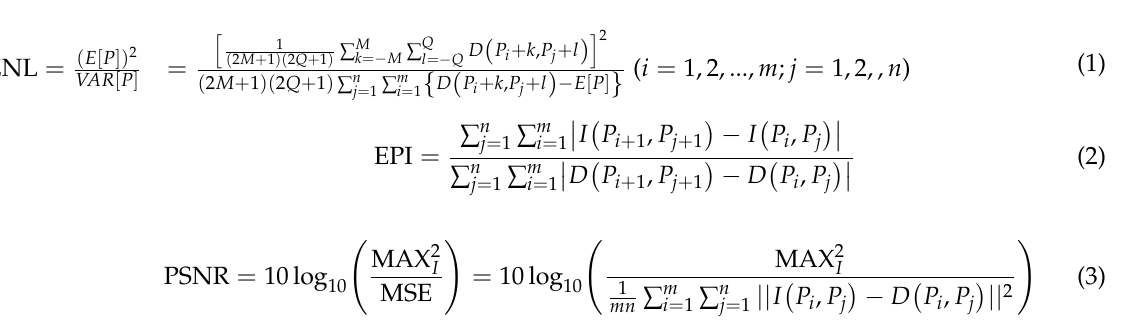
where I and D represent the original image and the denoised image with a size of m × n , respectively; P is the intensity of the pixels; E and VAR are the mean and variance of P ; ( P ) is the position of the pixel in the selected area; M and Q are the window functions i , P j used in the calculation, usually both assigned values of two; MAX I is the maximum value of the image point color; MSE is the mean-squared deviation of the image.